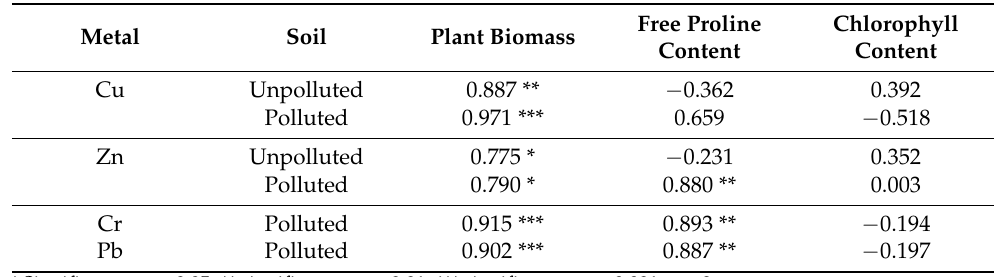
Table 13. Pearson correlations between metal concentration and biomass, free proline and chlorophyll content in S. perfoliatum plants grown in Ps and